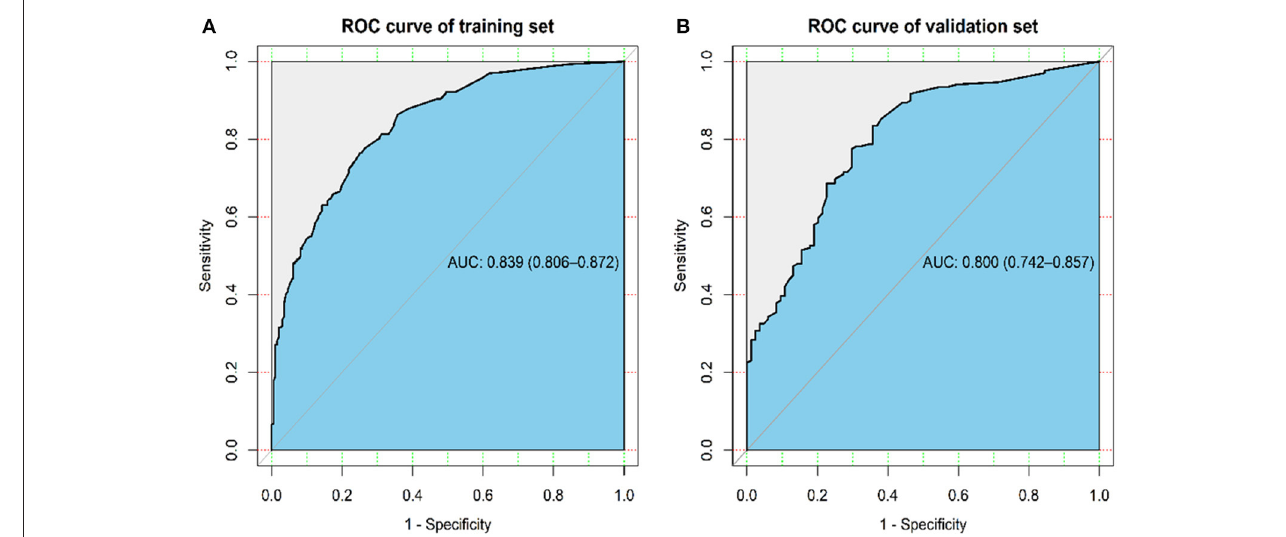
FIGURE 3 | ROC curve and AUC for prediction model in the training (A) and validation set (B)